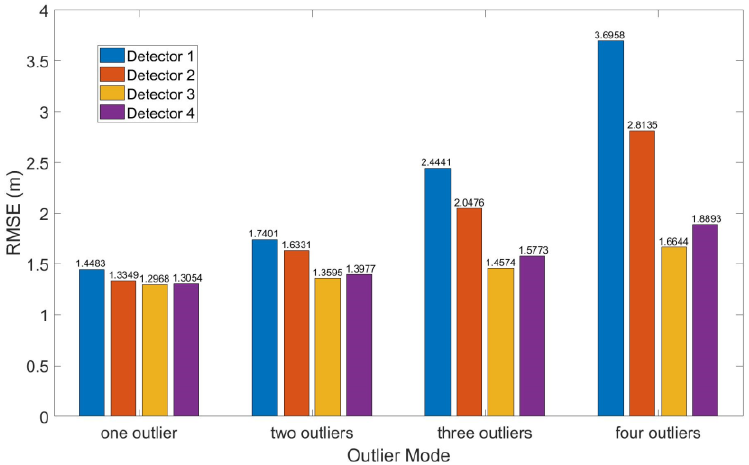
Figure 13. Root mean squared error (RMSE) of four detectors in Case 3. Table 5. The statistical results of four detectors in Case 3.